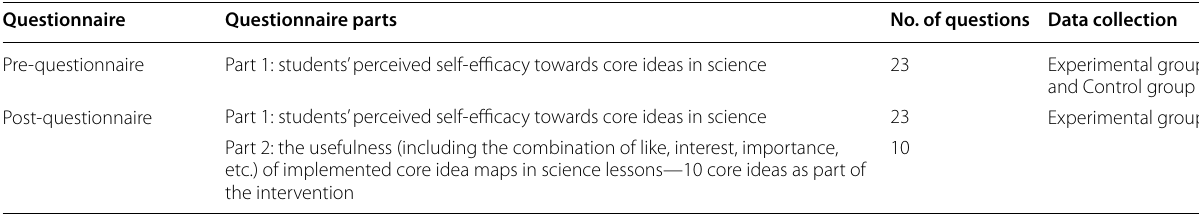
Table 2 Overview of the questionnaires